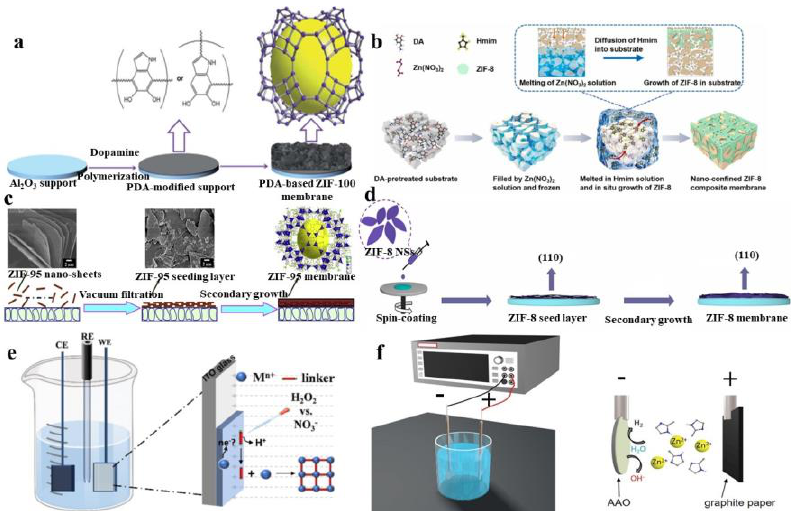
Figure 1. Various methods of preparing MOF membrane. ( a ) Preparation of ZIF-100 using the in situ growth method. ( b ) Preparation of ZIF-8 membrane using the freezing-assisted in situ growth method. ( c ) Preparation of ZIF-95 membrane using the secondary growth method. ( d ) Preparation of ZIF-8 membrane using the secondary growth method at a low temperature. ( e ) Preparation of MOF membranes by cathodic deposition. ( f ) Preparation of ZIF-8 membranes by aqueous cathodic deposition.